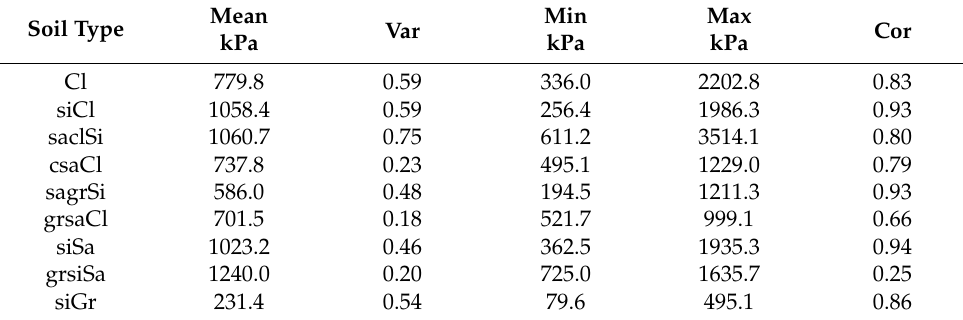
Table 3. Statistics of plunger stress for individual soil